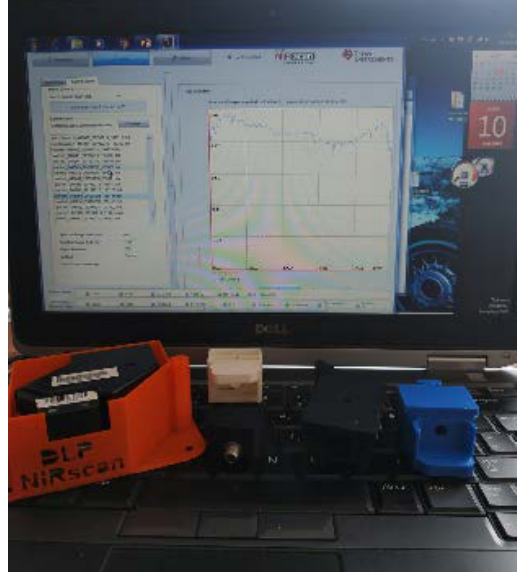
Figure 4. Actual view of the test stand—additional adapters for DLP are